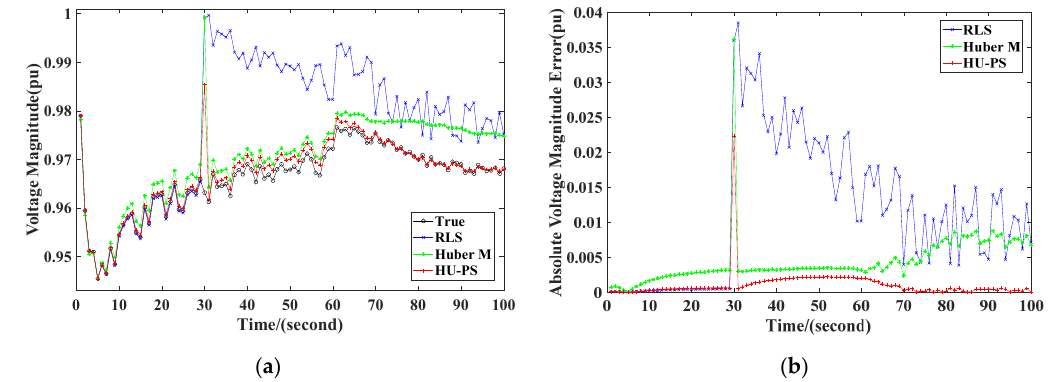
Figure 10. Values in scenario 1: ( a ) voltage magnitude, ( b ) absolute voltage magnitude error.